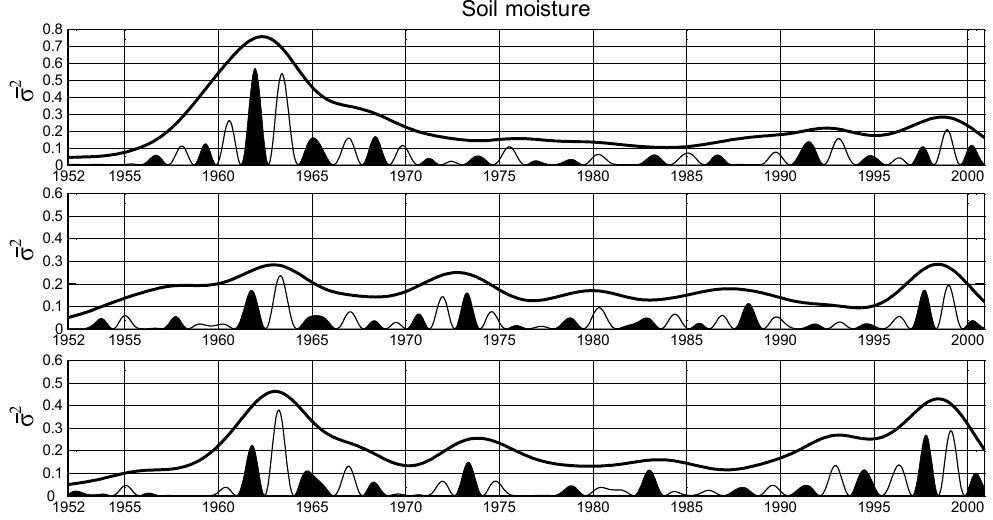
Fig. 7. Same as Fig. 5, but for soil moisture in the 1.92–5.21yr band. The averaged variances of initial monthly soil moisture time series σ 2 for the first, second and third modes are 792.45, 1151.50 and 911.17mm 2 , respectively. Fig. 7. Same to Fig. 5, but for soil moisture in 1.92–5.21 yr band. The averaged variances of initial monthly soil moisture time series 2  for the first, second and third Fig. 9a (right panel) are found within the 1–2 yr band around modes are 792.45 mm 2 , 1,151.50 mm 2 and 911.17 mm 2 , respectively. 1975 (anti-phase), and within the 2–4 yr band around the pe- riod 1990–1995 (close